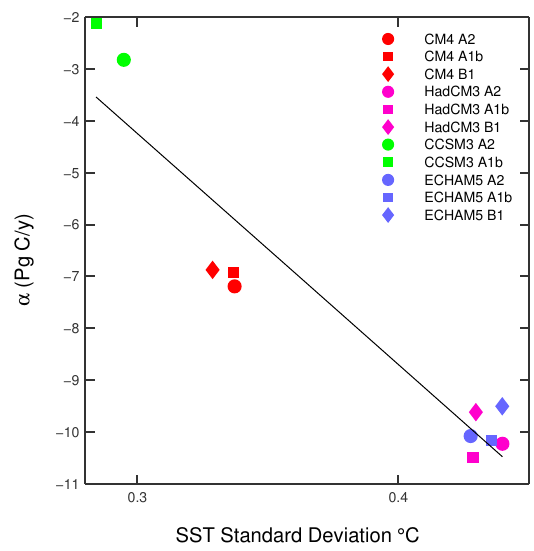
Fig. 4. Relation between the simulation-specific parameter α and Figure 4. Relation between the simulation-specific parameter α and global SST variability. 2 global SST